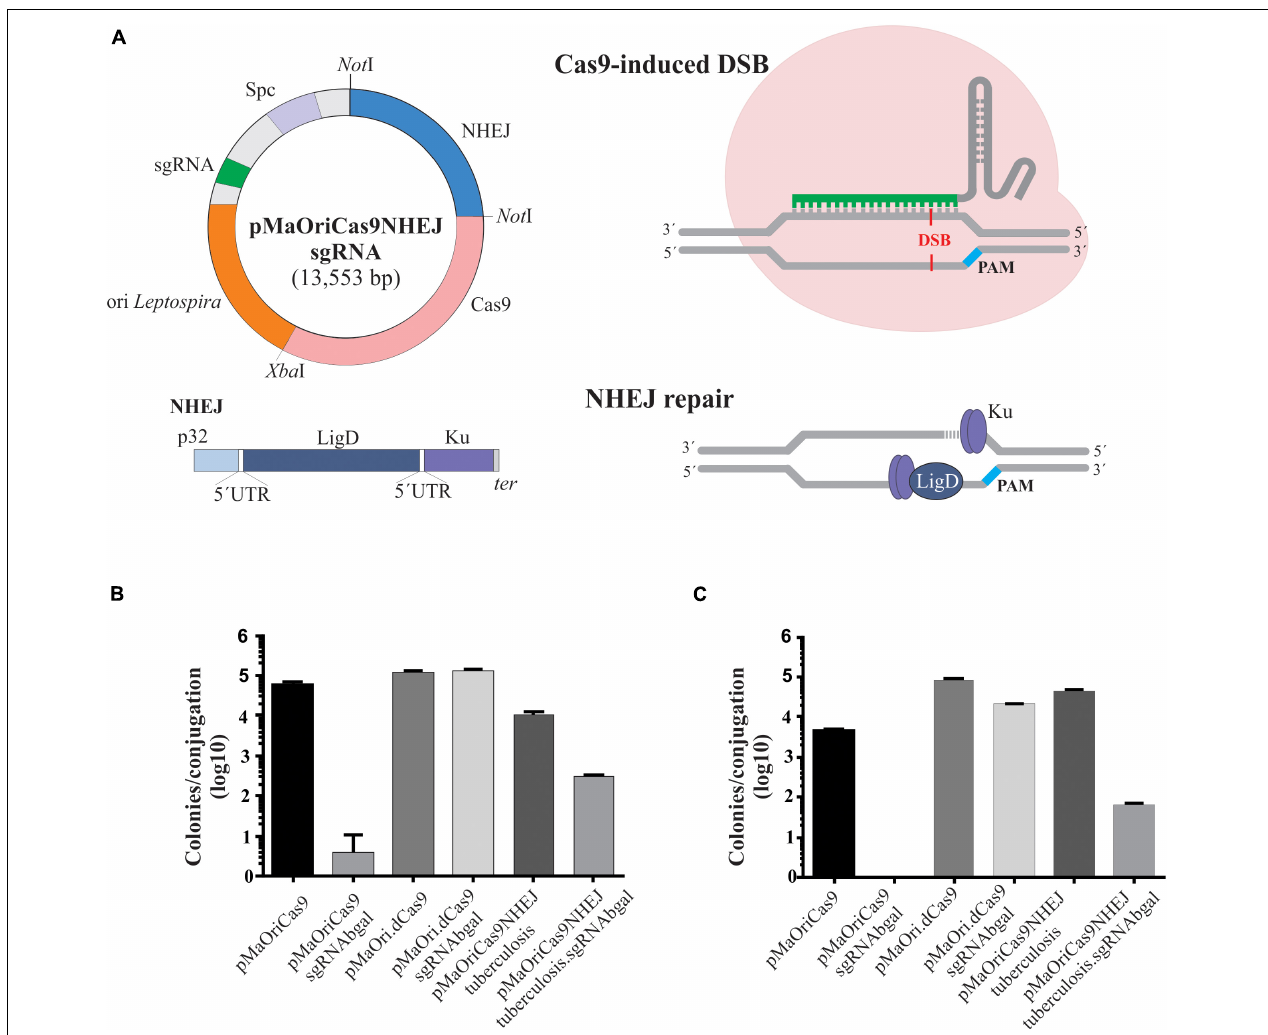
FIGURE 1 | Description of NHEJ repair strategy and assessment of transconjugant recovery in L. biflexa . (A) NHEJ cassette, comprising M. tuberculosis ligD and ku genes under the control of leptospiral lipL32 promoter, was ligated into pMaOriCas9 plasmids. Programmable Cas9 enzyme, guided by the sgRNA, will provoke a DSB in the desired genomic target, which would be further repaired by the action of LigD and Ku proteins. (B,C) Distinct plasmids were transferred to L. biflexa cells by conjugation with E. coli β 2163 and then plated onto EMJH plus spectinomycin plates at different dilutions for cell enumeration. Values are expressed in colonies per conjugation ion log